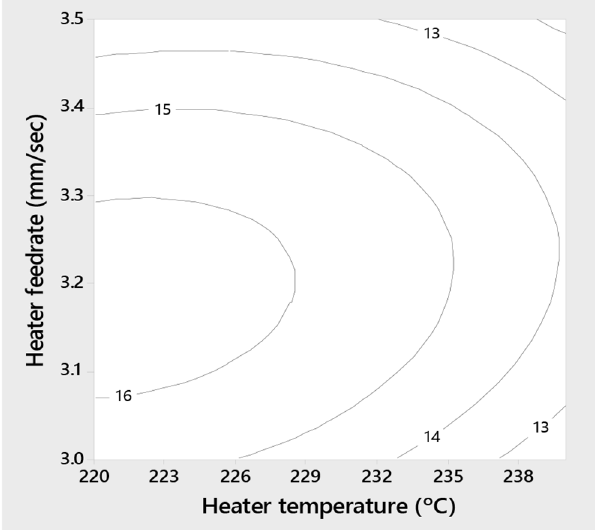
Fig. 12. Contour plot of fatigue strength versus layer thickness and heater feed rate.